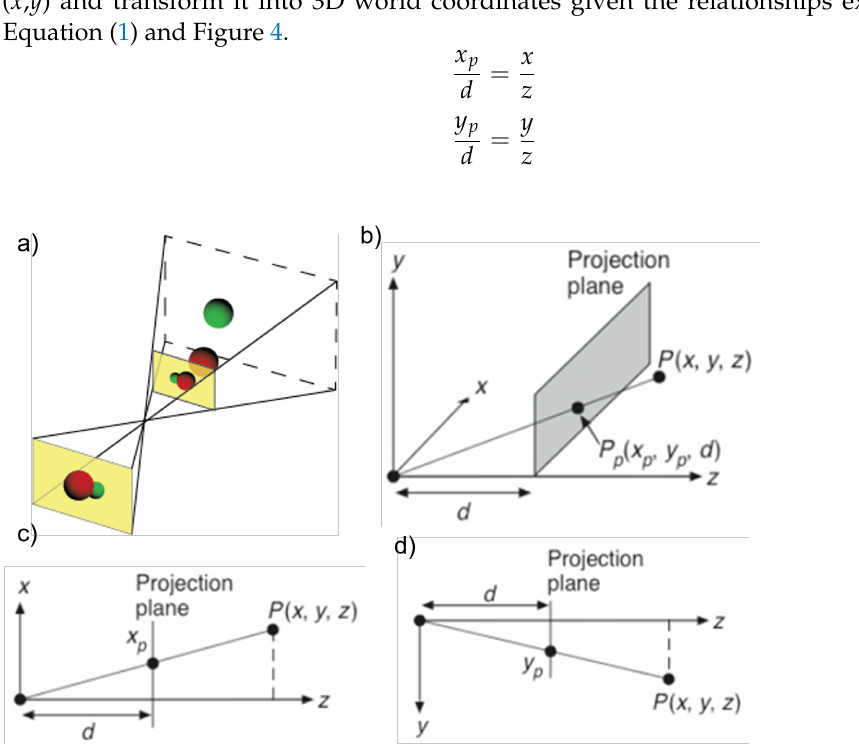
Figure 4. Representation of the angular similarity process. ( a ) Projection of the front of the camera. ( b ) Representation without considering main points. ( c ) The x-axis view. ( d ) The y-axis view